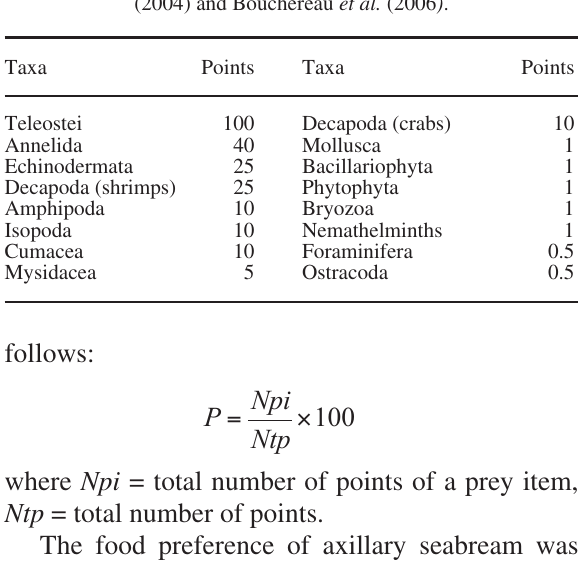
Table 1. – Points given to food items of the diet of P. acarne in relation to their digestibility and size according to Pasquaud et al. (2004) and Bouchereau et al. (2006 ) .